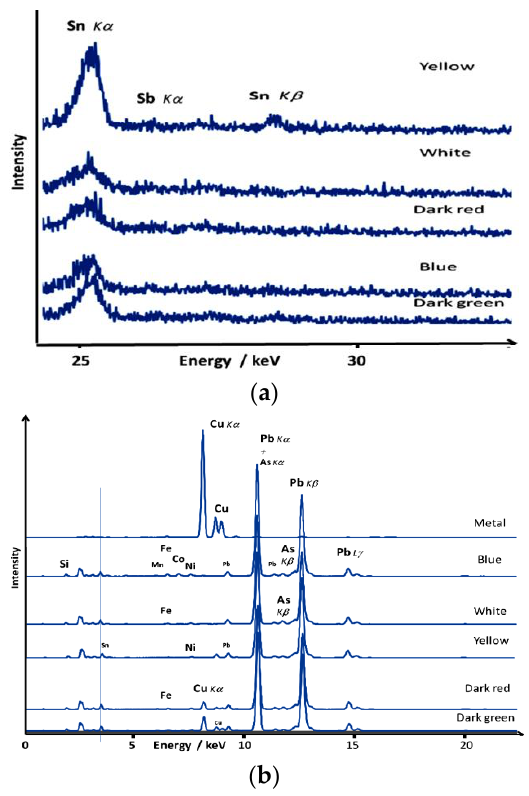
Figure 11. Representative portable X-ray fluorescence spectrometry (pXRF) spectra recorded on the R975 bottle for the metal and enamelled areas with different colours. A zoom of the region showing Sn and Sb elements is given in a).